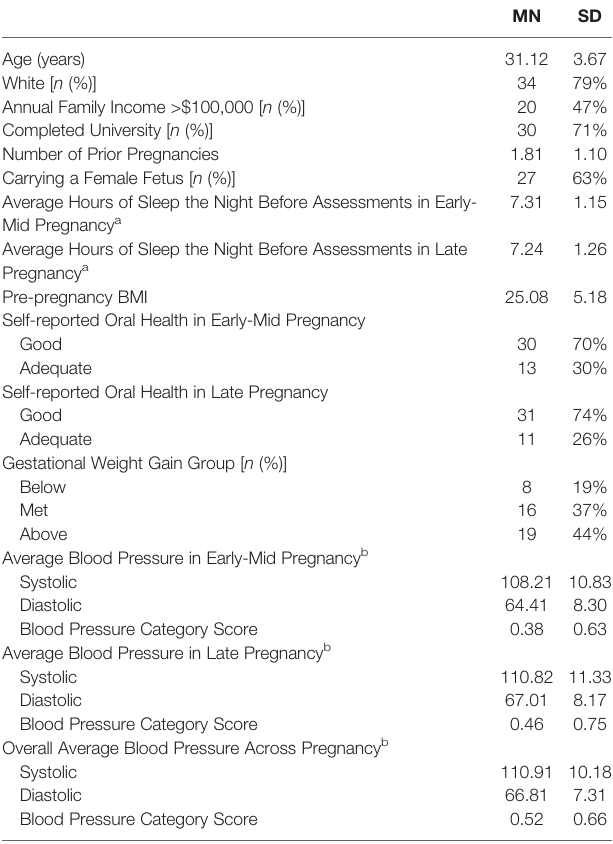
TABLE 1 | Sample characteristics (N=43 healthy pregnant